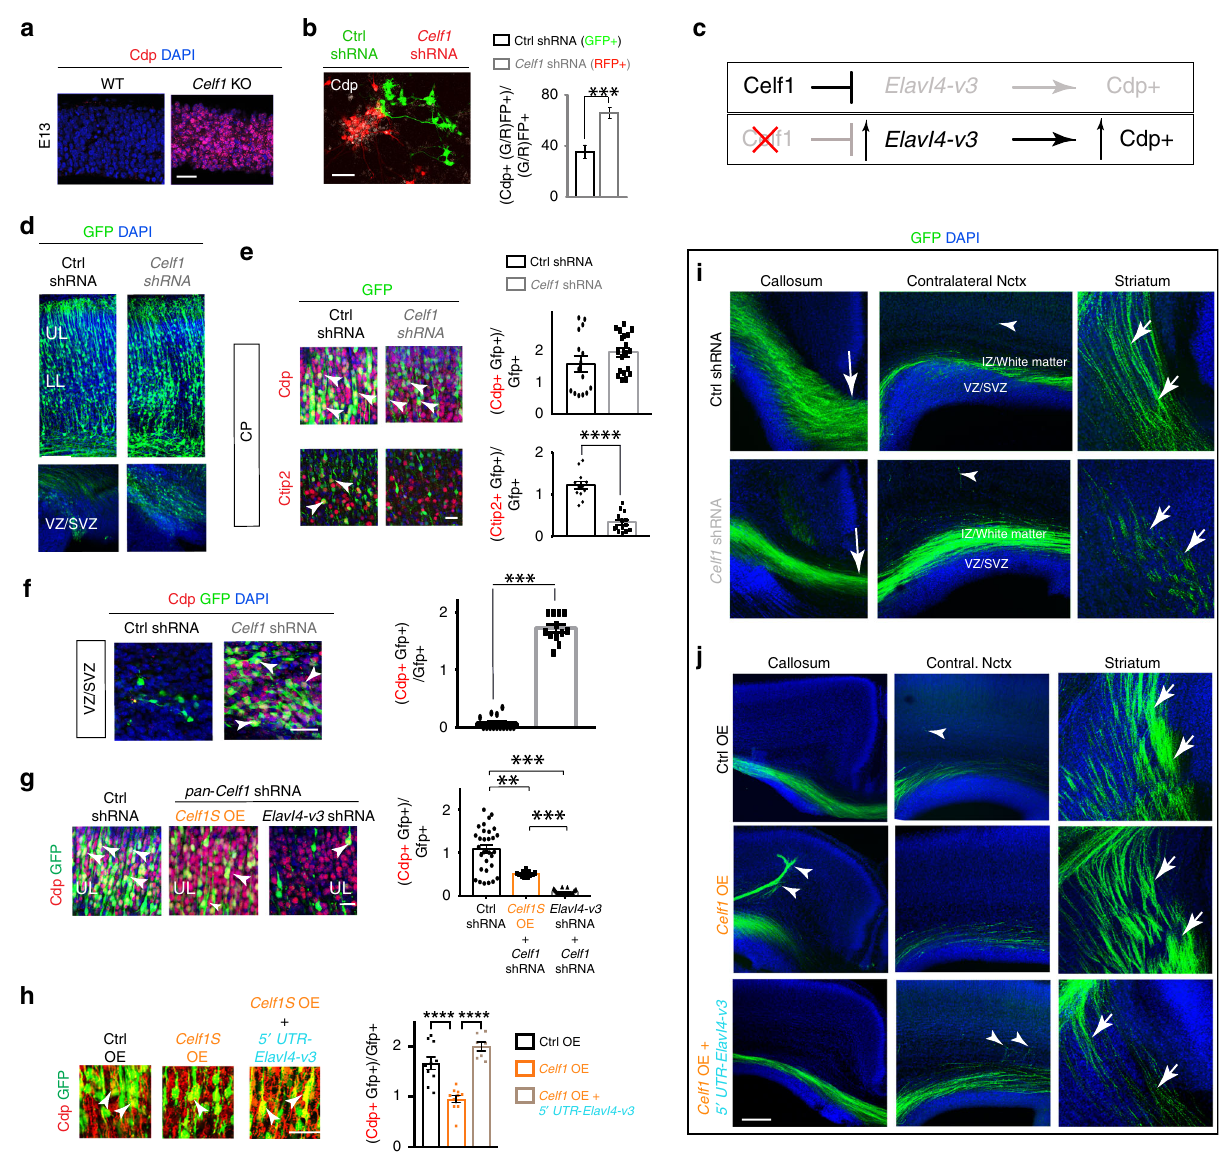
Fig. 8 Celf1 regulates development of glutamatergic neurons in developing neocortices through Elavl4 . a Neocortical E13 VZ of WT ( n = 6 animals) and Celf1 KO ( n = 2 animals). IHC for Cdp (red). DAPI shown in blue. Scale bar: 100 μ m. b (left) Representative IHC of three days in vitro primary neocortical neuronal cultures. Transfected neurons are expressing GFP (Ctrl shRNA) or RFP ( Celf1 shRNA) and neuronal identity marker Cdp (white). Scale bar: 40 μ m. (right) Quanti fi cation of Cdp colocalization. Data represent the mean and SEM. N = 1 litter (14 embryos). Statistics: Students t -test. *** p < 0.001. c Schematic: Celf1 translationally represses Elavl4-v3 , which decreases Cdp + identities. Once Celf1 is silenced, Elavl4-v3 translation is derepressed, increasing Cdp + identities. d P0 representative confocal images of E13 IUE neocortices electroporated with CAG-GFP and either Ctrl shRNA ( n = 5 animals) or Celf1 shRNA ( n = 4 animals) at E13. Ventricular zone/subventricular zone (VZ/SVZ) shown underneath. GFP is green. DAPI shown in blue. Scale bar: 100 μ m. UL = upper layers, LL = lower layers. e (left) P0 representative confocal images of transfected neocortices in d , immunostained for cortical neuronal identity markers Cdp and Ctip2 in CP. Arrowheads indicate colocalization. Scale bar: 40 μ m. (right) Quanti fi cation of Cdp and Ctip2 colocalization. Data represent the mean and SEM. Statistics: Student ’ s t -test. *** p < 0.001. f (left) Representative confocal images of transfected neocortices in e , immunostained for cortical neuronal identity marker Cdp in VZ/SVZ. Arrowheads indicate colocalization. Scale bar: 40 μ m. (right) Quanti fi cation of Cdp colocalization. Data represent the mean of sections and SEM. Statistics: Student ’ s t -test. *** p <0.001. g (left) P0 representative confocal images of E13 IUE neocortices electroporated with CAG-GFP and either Ctrl shRNA ( n = 5 animals), Celf1 shRNA and Celf1 OE ( n = 3 animals), or Celf1 shRNA and Elavl4-v3 shRNA ( n = 3 animals). IHC for GFP (green) and layer marker Cdp (red). Arrowheads indicate colocalization. Scale bar: 40 μ m. UL = upper layer. (right) Quanti fi cation of Cdp colocalization. Data represent the mean of sections and SEM. Statistics: one-way ANOVA with Tukey ʼ s. * p < 0.05, *** p < 0.001, n.s. = not signi fi cant. h (left) P0 representative confocal images of E13 IUE neocortices electroporated with GFP and either Ctrl ( n = 4 animals), Celf1 OE ( n = 3 animals), or Celf1 OE and 5 ′ UTR-Elavl4-v3 ( n = 3 animals) OE plasmids IHC for GFP (green), and cortical layer identity markers Cdp (red). Arrowheads indicate colocalization. DAPI shown in blue. Scale bar: 40 μ m. (right) Quanti fi cation of Cdp colocalization. Data represent the mean and SEM. Statistics: one-way ANOVA with Tukey ʼ s. *** p < 0.001. i , j Representative confocal images of the corpus callosum, contralateral neocortex, and striatum of P0 neocortices that underwent IUE with GFP and either Ctrl shRNA (n = 5 animals) or Celf1 shRNA ( n = 4 animals) ( i ) or either Ctrl OE ( n = 3 animals), Celf1 OE ( n = 3 animals), or Celf1 OE and 5 ′ UTR-Elavl4-v3 ( j ). Scale bar is 200 μ